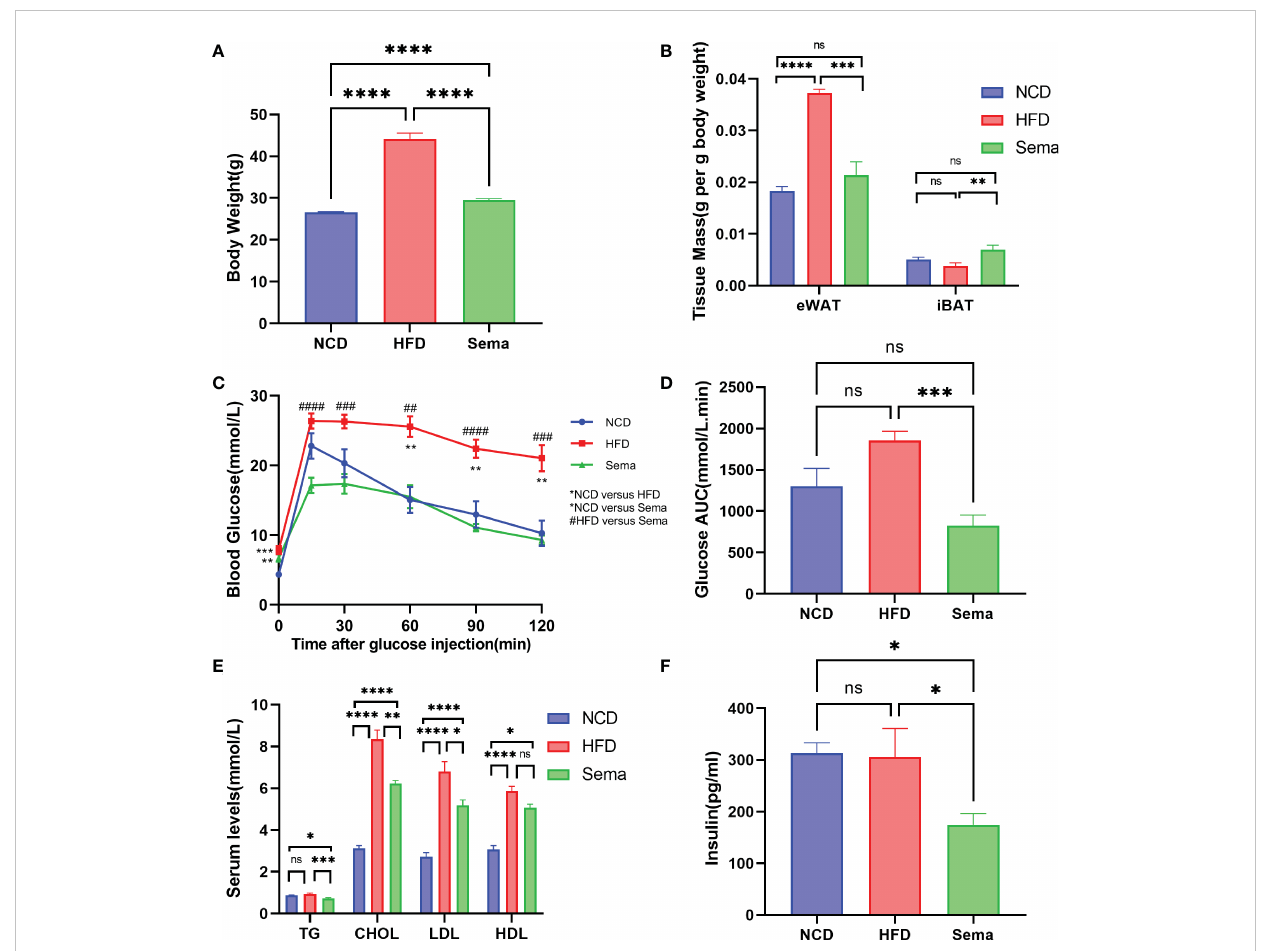
FIGURE 2 The effects of semaglutide on reducing body weight and visceral obesity and improving metabolic pro fi les. (A) Average body weight of each group before being sacri fi ced (n=8). (B) Fat mass/body weight ratio (n=8). (C, D) i.p. GTT after semaglutide treatment and area of the curve (AOC) generated by the area under the curve (AUC), with subtraction of the basal glucose (n=8). (E, F) Determination of serum TC, TG, LDL-C, HDL-C, and insulin concentration (n=8); Data were presented as mean ± SEM. “ ns ” p > 0.05, *p<0.05, **p<0.01, ***p<0.001, ****p<0.0001, # p < 0.05, ## p<0.01, ### p<0.001, #### p<0.0001. NCD, normal control; HFD, high-fat diet-induced mice; Sema, HFD diet treated by